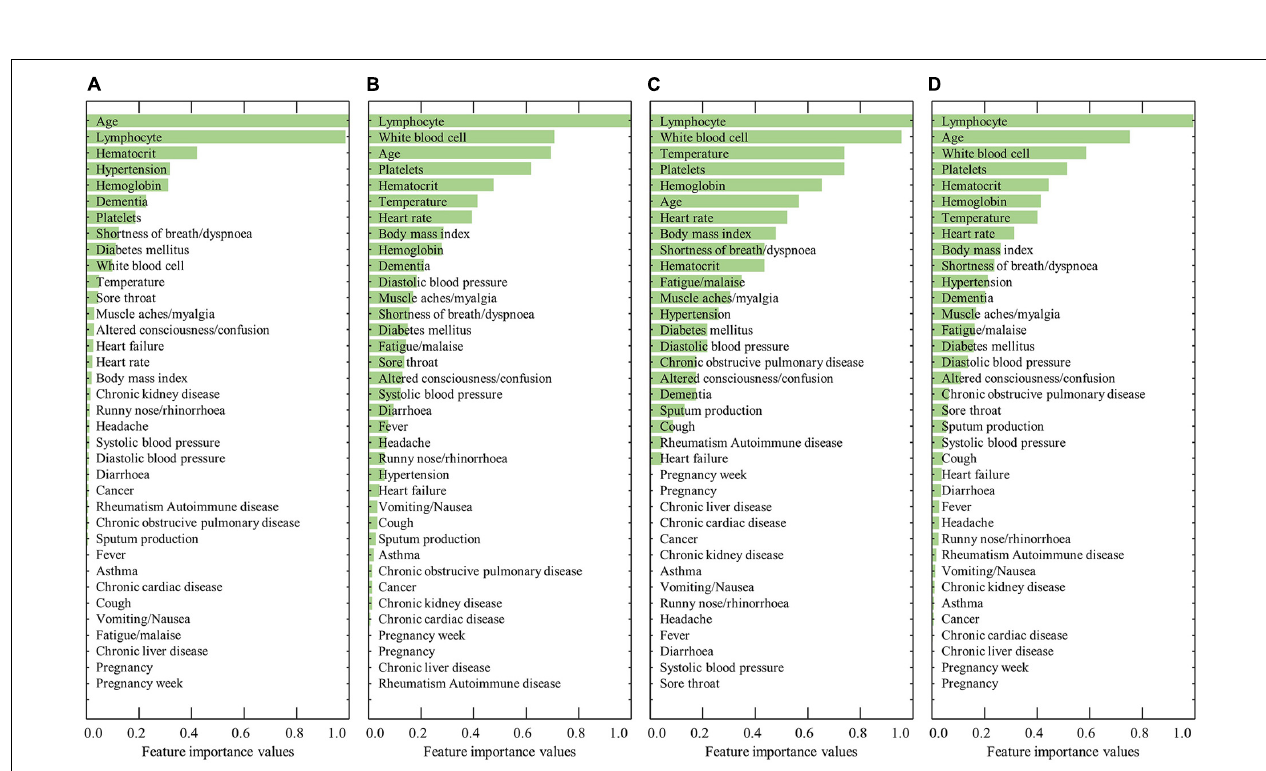
FIGURE 2 | Results of the ranked feature importance values for the female group using (A) RF, (B) XGBoost, (C) AdaBoost, and (D) average after normalization.